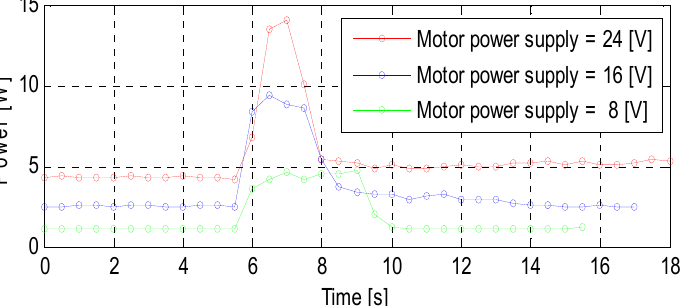
Figure 3. Power consumption during drillability test performed for black foamglas F sample using Makita coring bit for three different motor’s power supply voltage: 24, 16, and 8 V. WOB = 27.27 N.